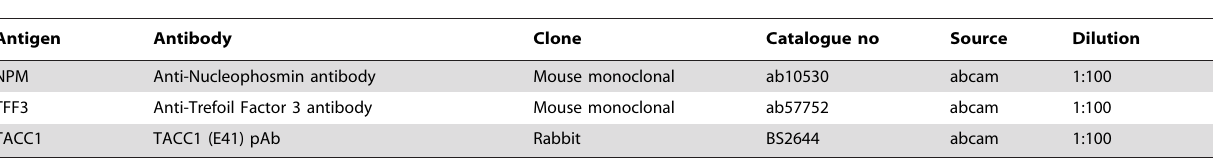
Table 1. Antibody used in this study.